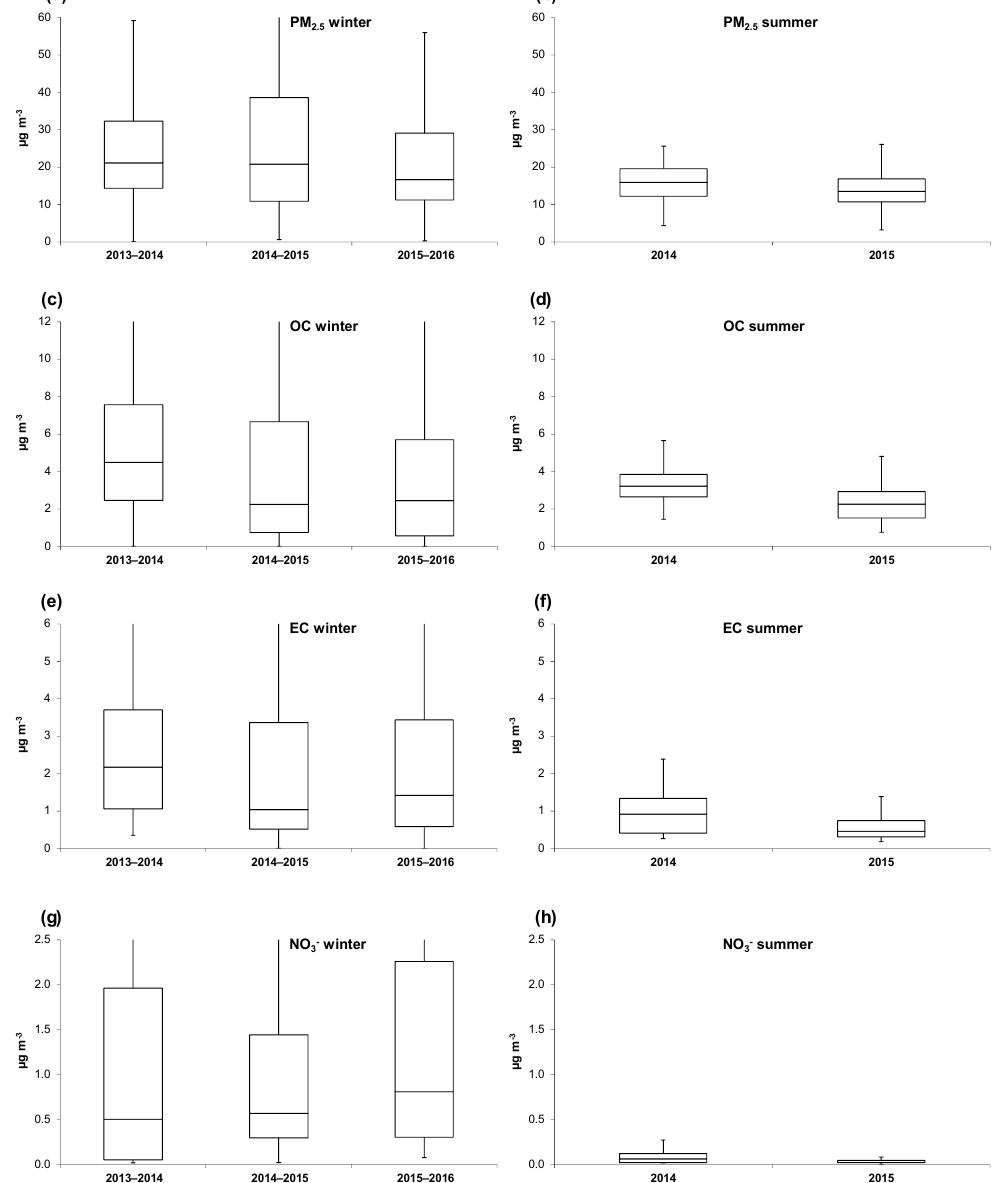
Figure 4. Winter and summer interquartile range (µgm − 3 ) for PM 2 . 5 mass, OC, EC, and NO − for the studied period from December 2013 to March 2016. The ends of the whisker are set at 1 . 5 · IQR above the third quartile (Q3) and 1 . 5 · IQR below the first quartile